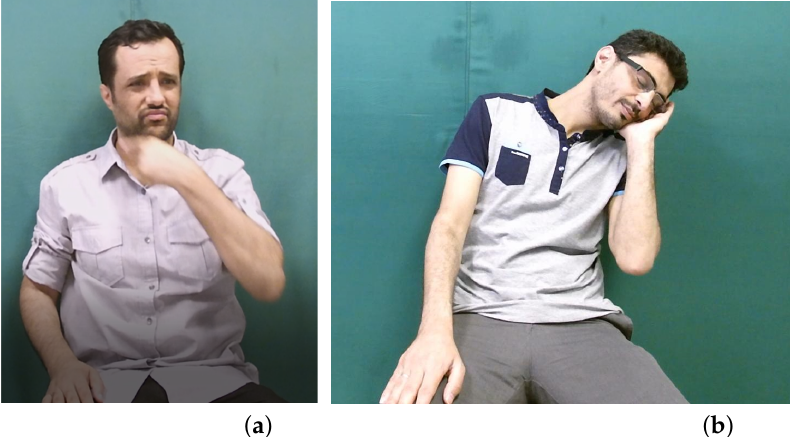
Figure 1. Two signs showing the employment of facial expressions with manual gestures: ( a ) “UGLY”; ( b )